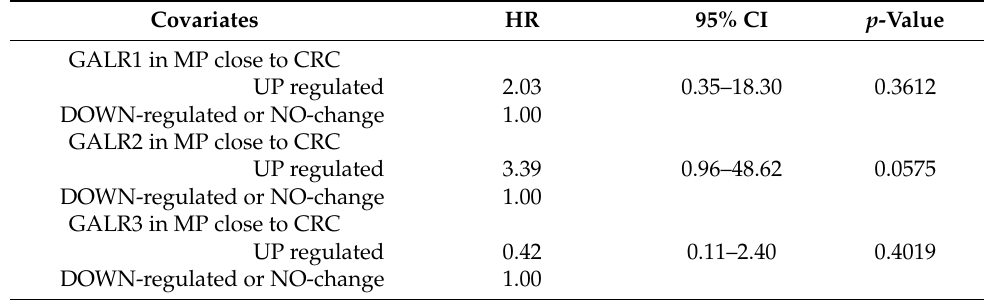
Table 2. Associations between demographic and clinico-pathological features of colorectal cancer patients (n = 31) and relative expression levels of galanin receptors in myenteric plexuses deter- mined by immunohistochemistry.